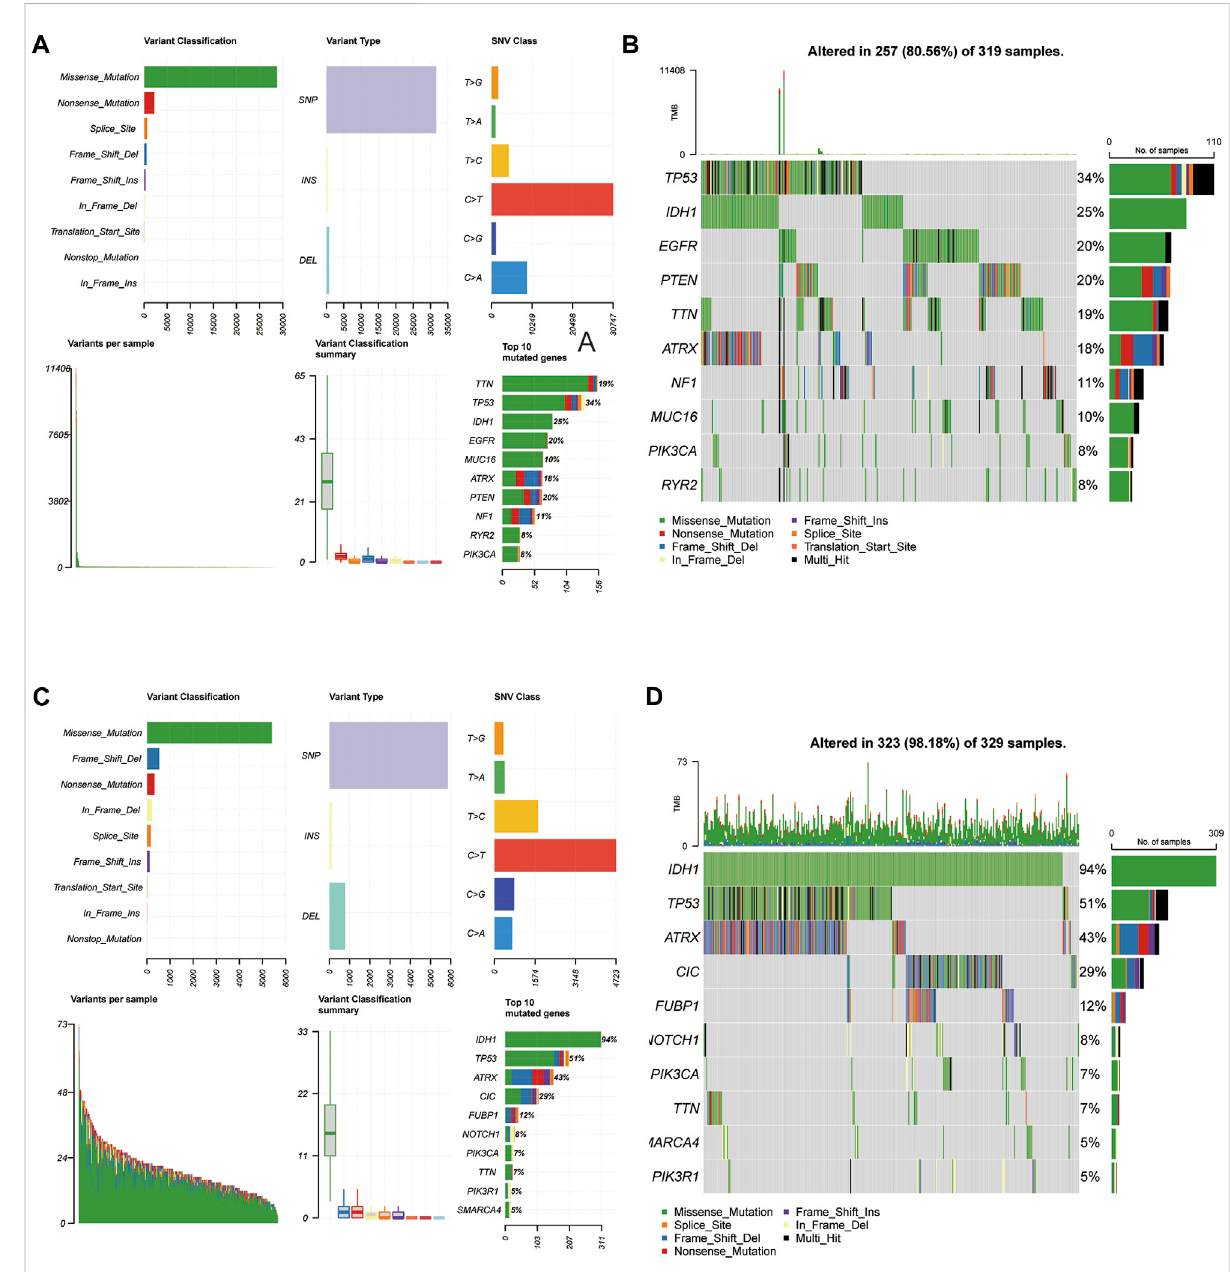
FIGURE 8 Somatic mutation analysis in high-risk and low-risk groups. (A,B) MAF-summary plots and oncoplots of somatic mutations in high-risk groups. (C,D) MAF-summary plots and oncoplots of somatic mutations in low-risk